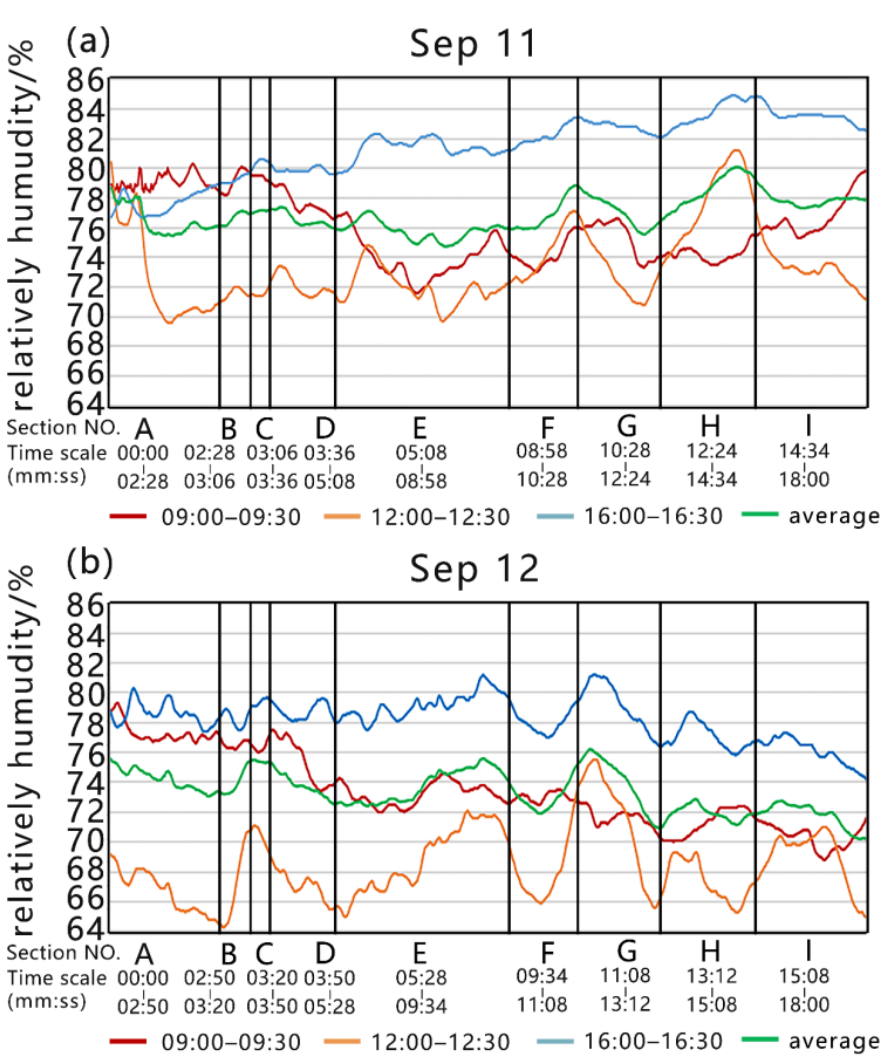
Figure 8. The line charts depicting the relative humidity changes over three time periods on 11 September (a) and 12 September (b).